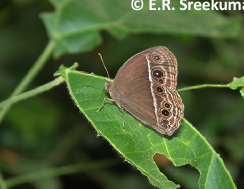
Image 7. Common Mormon Papilio polytes